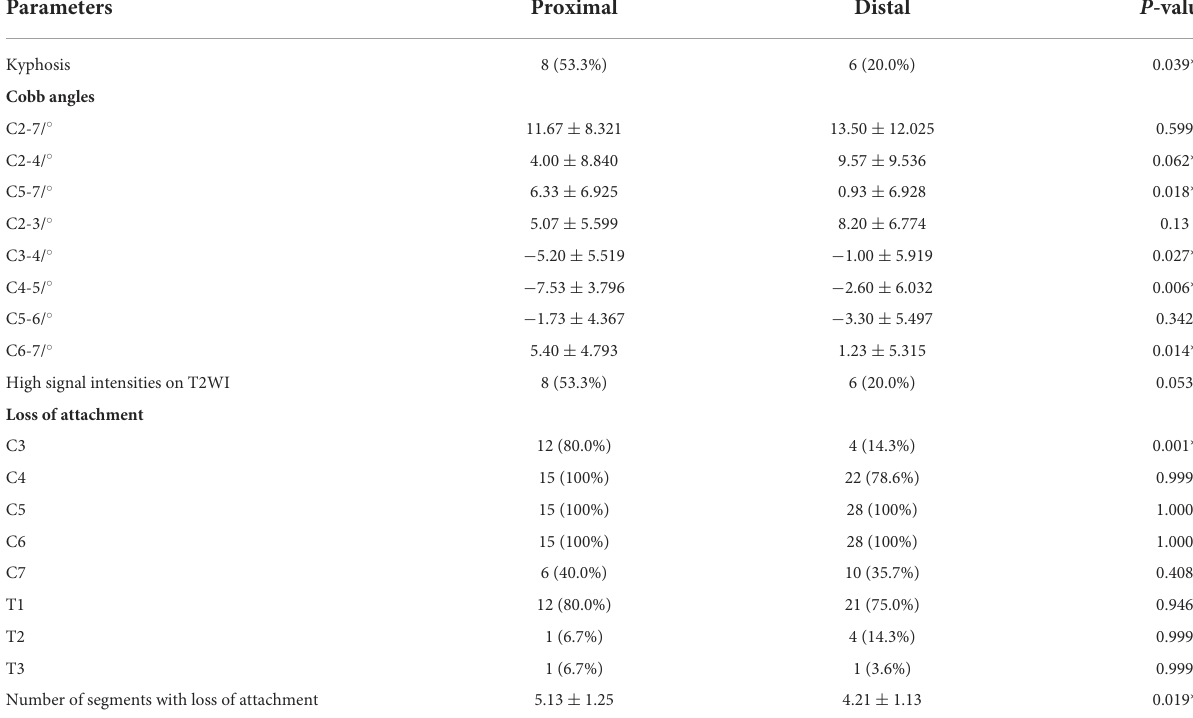
TABLE 3 The radiological characteristics of the proximal group and the simple distal group.